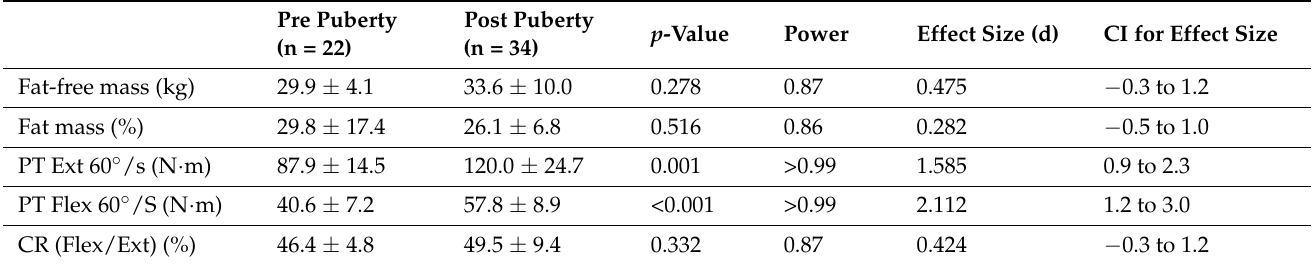
Table 4. Body composition and strength values for the girls’